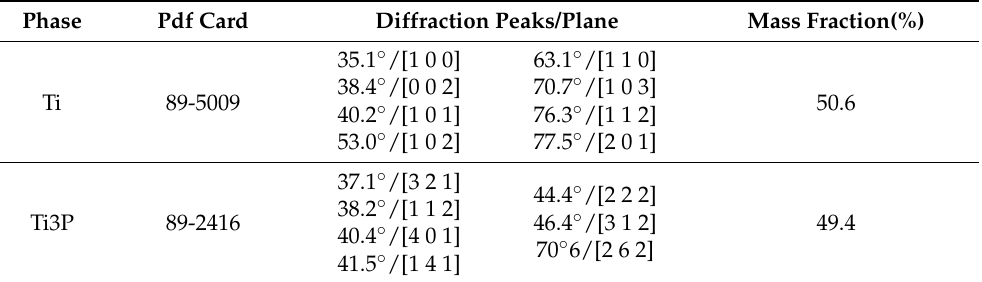
Figure 6. X-ray diffraction pattern of the phase of the transition layer. Table 6. The phases of the transition layer in the coating and their corresponding diffraction peaks, crystal planes, and phase mass fractions (RIR